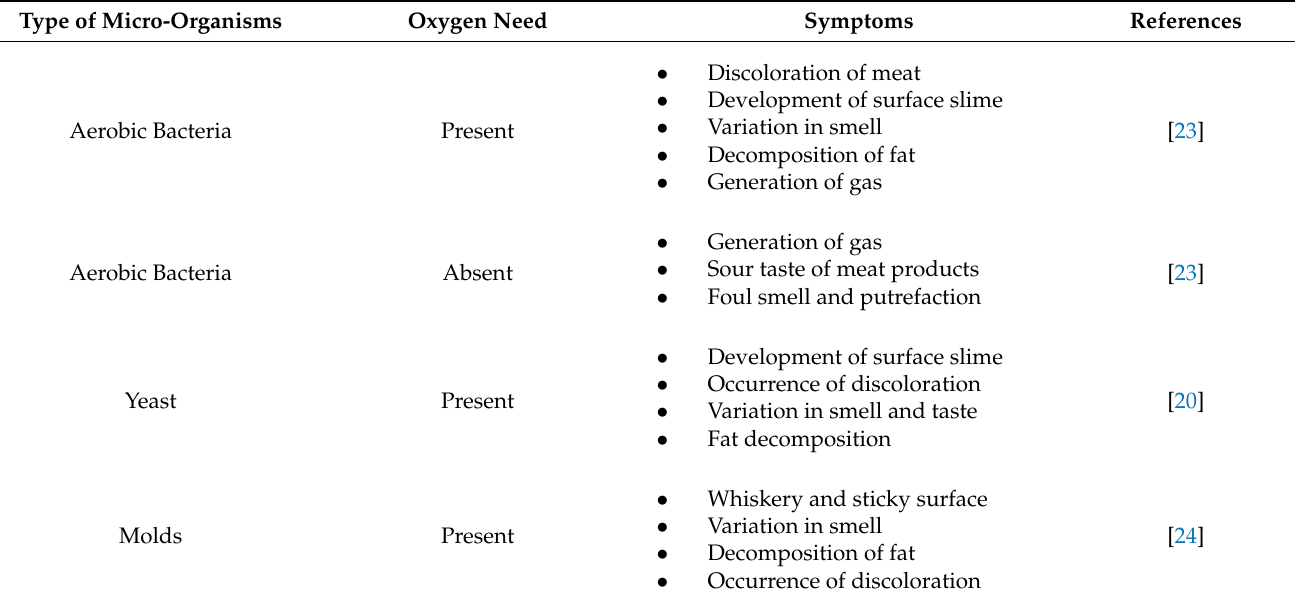
Table 1. Spoilage agents of meat and their impact on meat and meat product